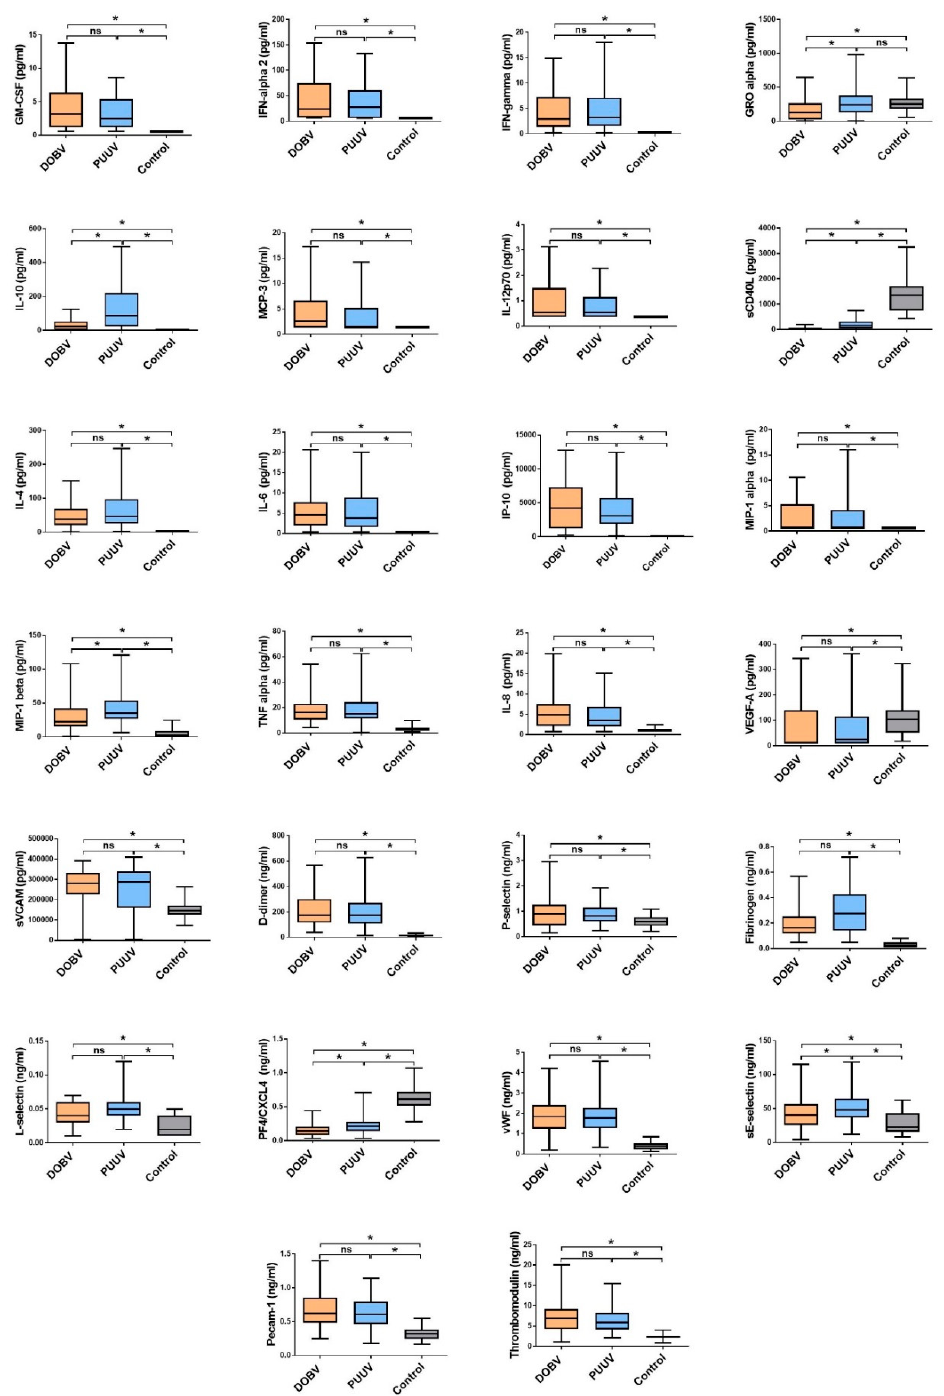
Figure 1. The cytokine and chemokine concentrations with significant differences in HFRS patients (DOBV, n = 50; PUUV, n = 50) in comparison to control group ( n = 30). The samples were obtained median 6 days after the onset of symptoms. The statistically significant differences are marked with * ( p < 0.05). ns= not statistically significant. The boxes represents medians with interquartile ranges; the whiskers depict minimum and maximum values (range). Identified outliers are not included in the figures above: IFN- γ (DOBV n = 4; PUUV n = 3), MCP-3 (DOBV n = 6; PUUV n = 5), IL-4 (DOBV n = 5; PUUV n = 5), MIP-1 α (DOBV n = 3; PUUV n = 8), IL-8 (DOBV n = 7; PUUV n = 4), VEGF-A (PUUV n = 6) and Fibrinogen (DOBV n = 8; PUUV n =